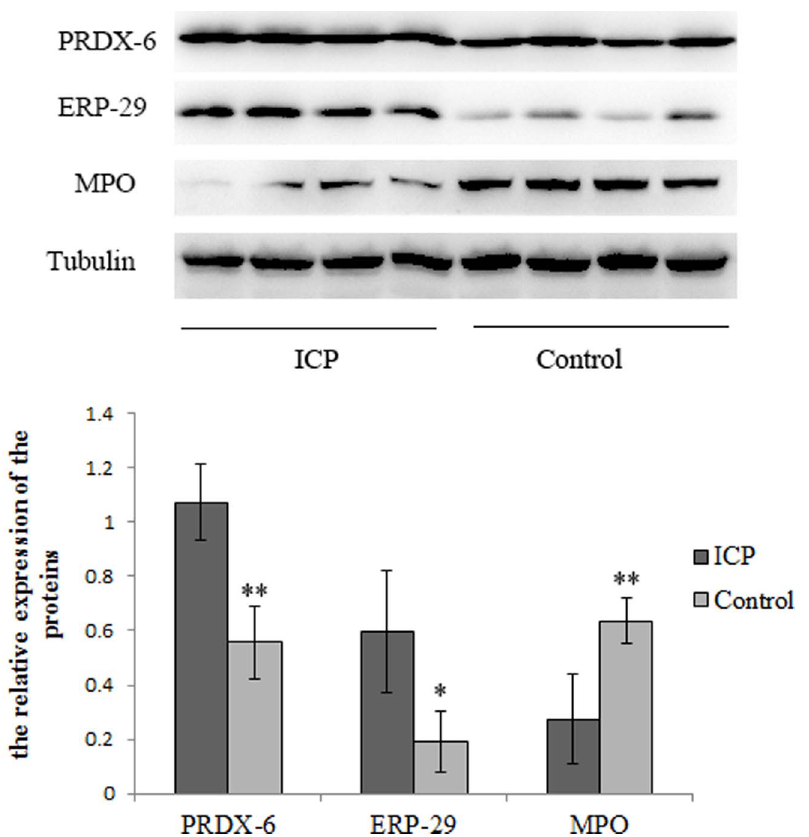
Figure 3. Western blot analysis of PRDX6, ERp29 and MPO in the placental tissue from pregnant women with ICP and healthy pregnant women. The expression levels of PRDX6 and ERp29 were significantly upregulated, whereas MPO was significantly downregulated in placenta from pregnant women with ICP compared to that in placenta from healthy pregnant women ( P =0.002, P =0.018 and P =0.009, respectively); b -tubulin was used as an internal control. ( *P , 0.05; **P , 0.01).